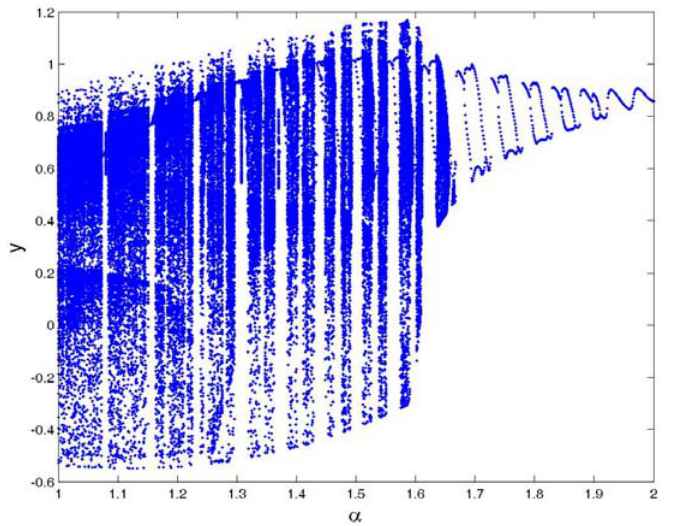
Figure 14. Bifurcation diagram of the equilibrium parameter α .